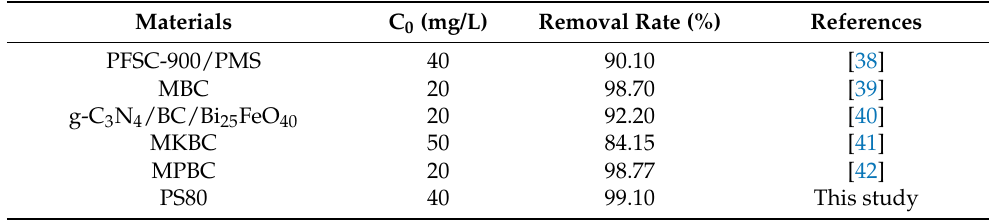
Table 5. Comparison of the removal capacity for TC with other materials reported in the literature.